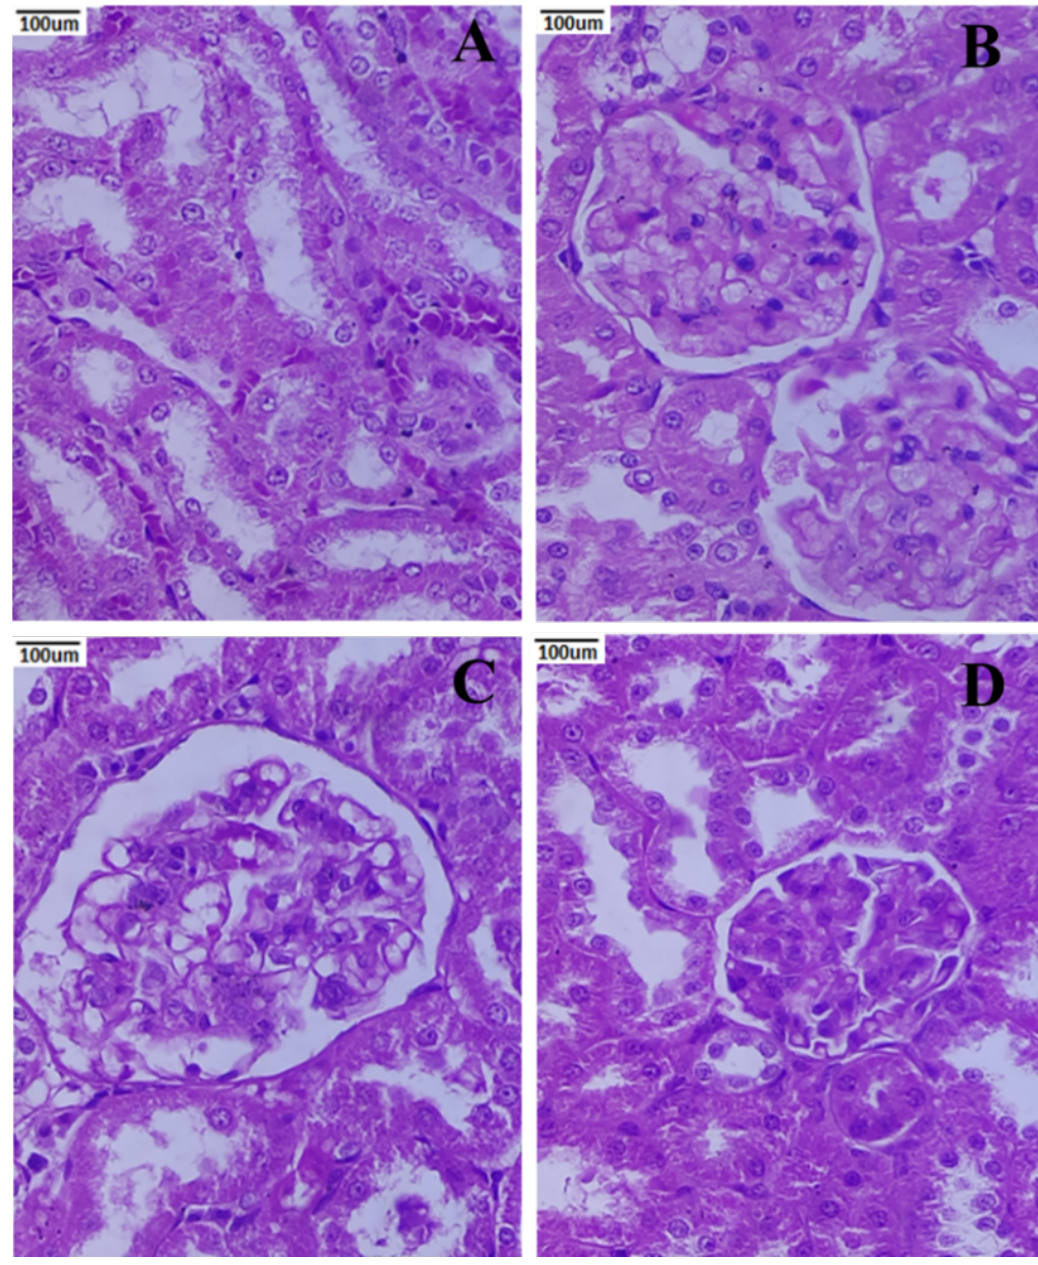
Figure 10. Activities of PCNPs on the kidney histopathological picture of DN rats (40×). ( A ) Normal photomicrograph of kidney shows a regular appearance of the glomerulus; ( B ) DN kidney shows glomerulosclerosis and vacuolation in tubular epithelial cells; ( C ) STZ + 80 mg/kg of PCNP-treated kidney shows the near-normal appearance of glomeruli and tubules; ( D ) 80 mg/kg of PCNPs only shows the normal histology cells.